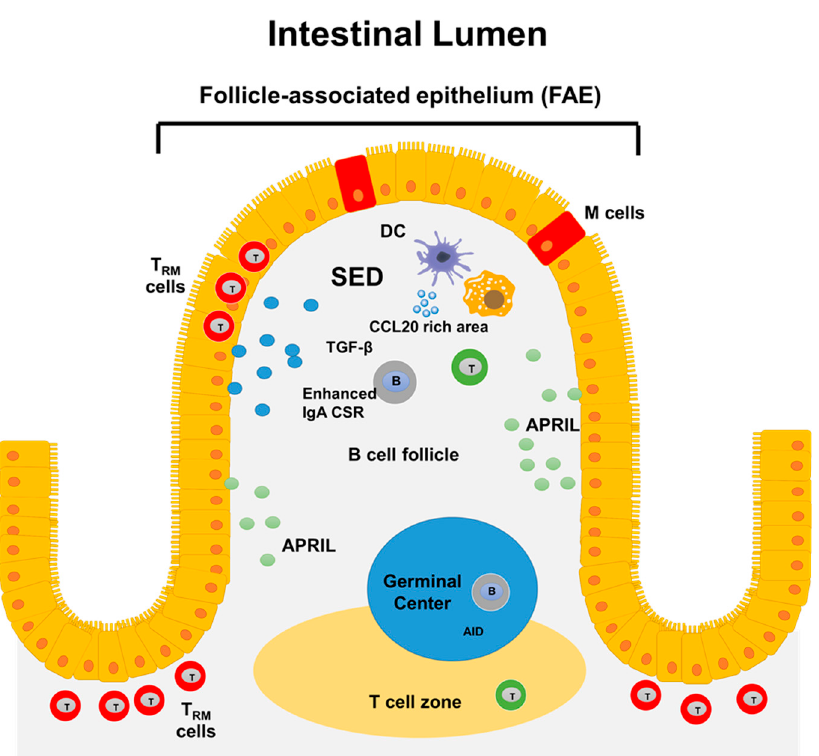
Figure 1. Structure of GALT . In the gut, antigens are sampled by follicle-associated epithelium (FAE) which contain microfold (M) cells. Next to M cells the sub-epithelial dome (SED) region is located. This region hosts multiple cell types, including different subsets of dendritic cells (DCs), macrophages, neutrophils, B, and T cells. Several factors that favor PCs survival (e.g., APRIL) and CSR to IgA (e.g., TGF- β ) are present in GALT. The GALT also contains germinal centers associated with T-cell zones for induction of immune responses at the local level. Finally, the human gut mucosa contains tissue-resident memory T cells, which show evidence of previous antigen encounter and appear to be long-lived.